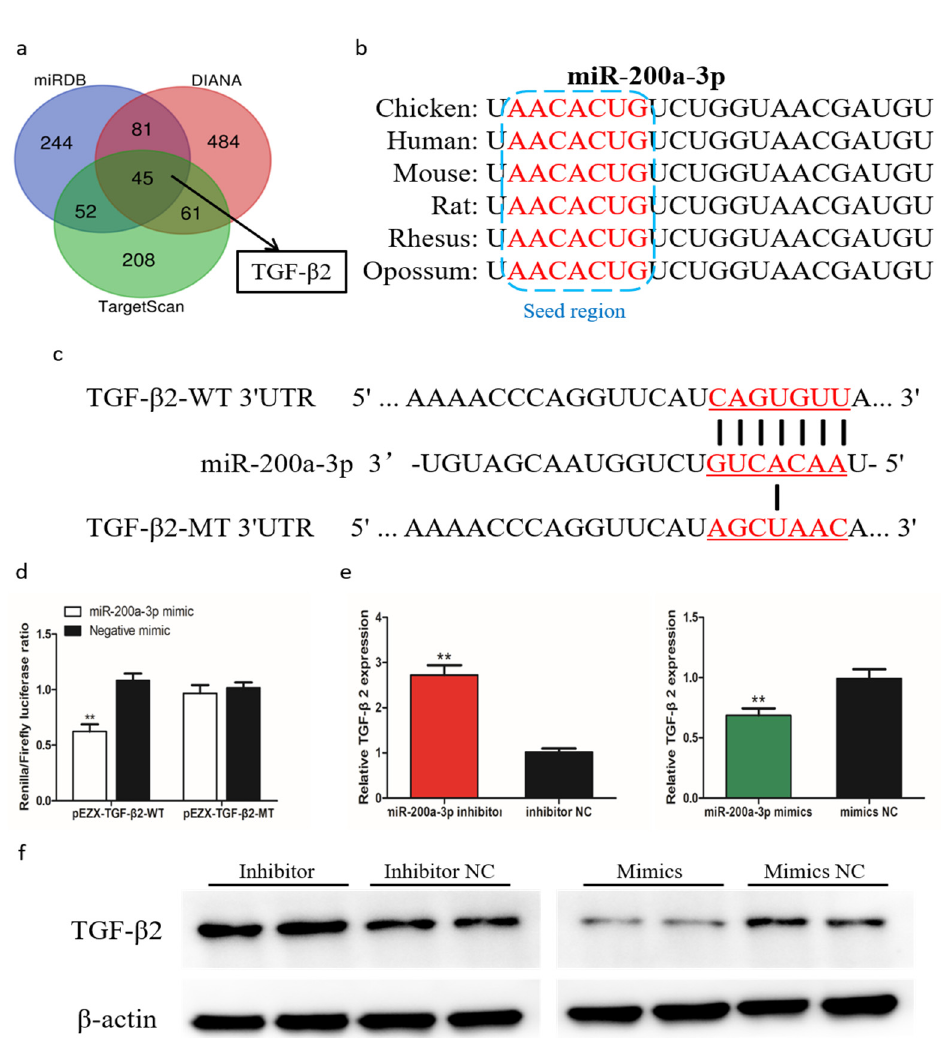
Figure 7. MiR-200a-3p directly targets TGF- β 2 in skeletal muscle satellite cells (SMSCs). ( a ) Prediction of target genes using TargetScan, miRDB, and Diana. ( b ) Seed region of miR-200a-3p. ( c ) Dual-luciferase reporter gene (pEZX-FR02) with wild type (pEZX- TGF- β 2 -WT) or mutant (pEZX- TGF- β 2 -MT). ( d ) Luciferase assays were performed by cotransfection of wild type or mutant TGF- β 2 3 ′ UTR with a miR-200a-3p mimic or mimic-NC in SMSCs. ( e , f ) After transfection of miR-200a-3p mimics, miR-200a-3p inhibitors or NC, the expression of TGF- β 2 was determined by q-PCR and Western blot. Data are expressed as mean ± SEM ( n = 3). * p < 0.05; ** p <